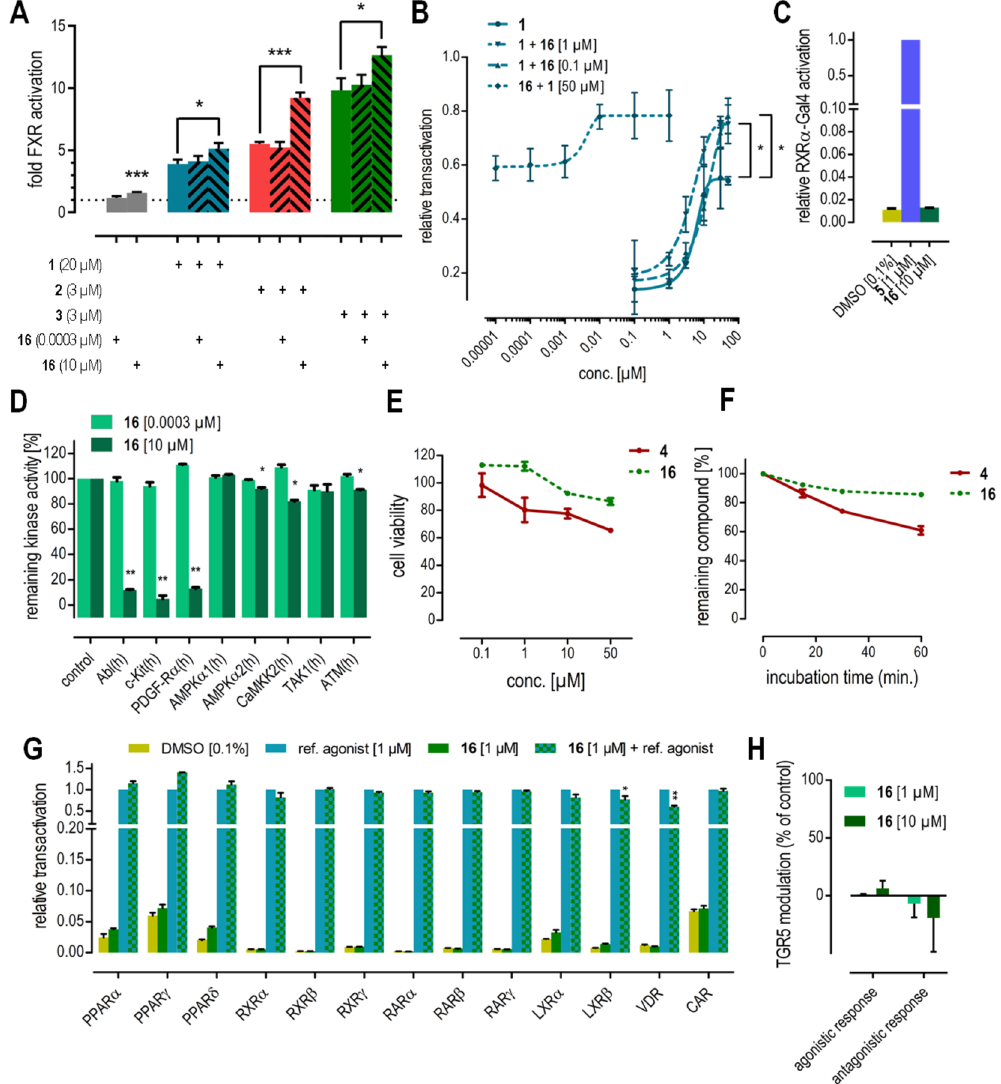
Figure 6. In vitro profiling of FXR modulator 16 . ( A ) At 10 µ M, 16 significantly enhances transactivation efficacy of FXR agonists 1 – 3 in a full-length FXR reporter gene assay. ( B ) Dose-response curves of FXR agonist 1 and compound 16 in presence of a fixed concentration of the respective other agent confirms increased maximum relative transactivation without marked changes in EC 50 -values. The maximum relative transactivation exceeds the sum of the single compounds’ maximum relative transactivation suggesting synergy. ( C ) 16 does not activate FXR’s heterodimer partner RXR. ( D ) 16 is a potent inhibitor of the kinases Abl, c-Kit and PDGF-R α but does not markedly inhibit kinases that interact with FXR. ( E ) 16 is less cytotoxic than 4 . ( F ) 16 possesses higher microsomal stability than 4 . ( G ) 16 is highly selective over nuclear receptors related to FXR. ( H ) 16 does not modulate the membrane bile acid receptor TGR5. * p < 0.05, ** p < 0.01, *** p <